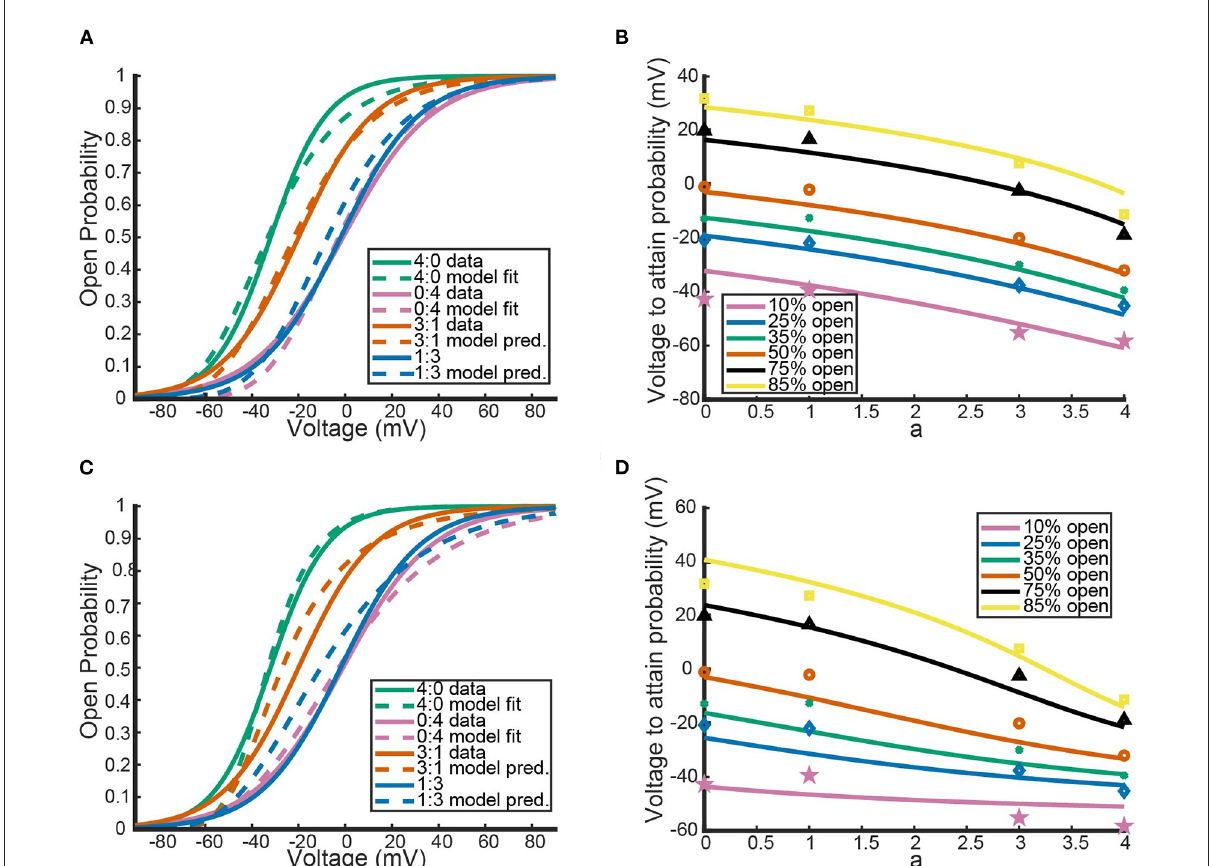
FIGURE5 The model’s performance relative to the Al-Sabi data using the K v 1.1 and K v 1.2 fit models with slope factors that are closest (A,B) and furthest (C,D) apart. Curve color and descriptions for (A,C) are identical to those given in Figure 2. Curve color and descriptions for (B,D) are identical to those given in Figure